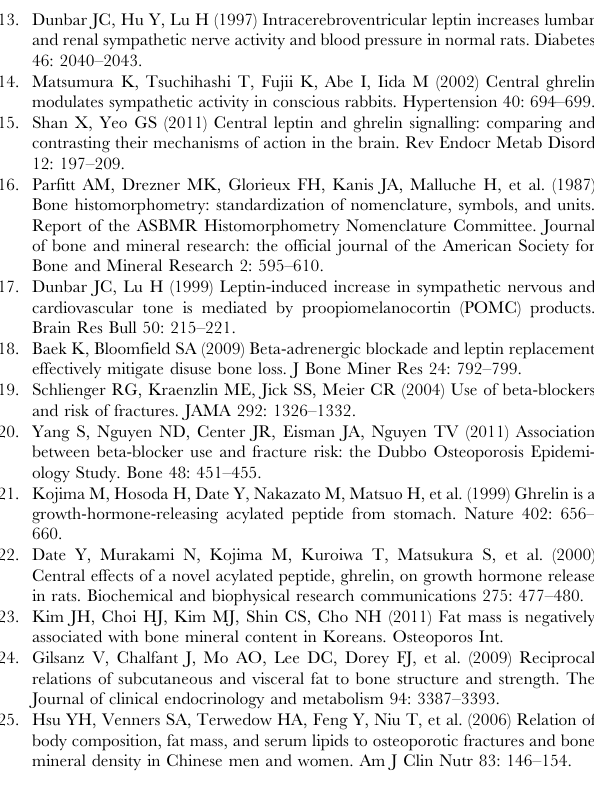
Figure S1 Effect of chronic ICV ghrelin infusion on the femur trabecular bone phenotype. (A) Trabecular bone volume expressed as percentage of total tissue volume (BV/TV). (B) Trabecular thickness (Tb.Th). (C) Trabecular number (Tb.N). (D) Trabecular separation (Tb.Sp). (E) Trabecular pattern factor (Tb.Pf). (F) Structure model index (SMI). (G) Trabecular volumetric BMD. (H) Representative microCT images of the distal femur. Three groups of rats (4–6 per group) were infused for 21 days with saline or ghrelin (1.5 m g/day). Rats infused with